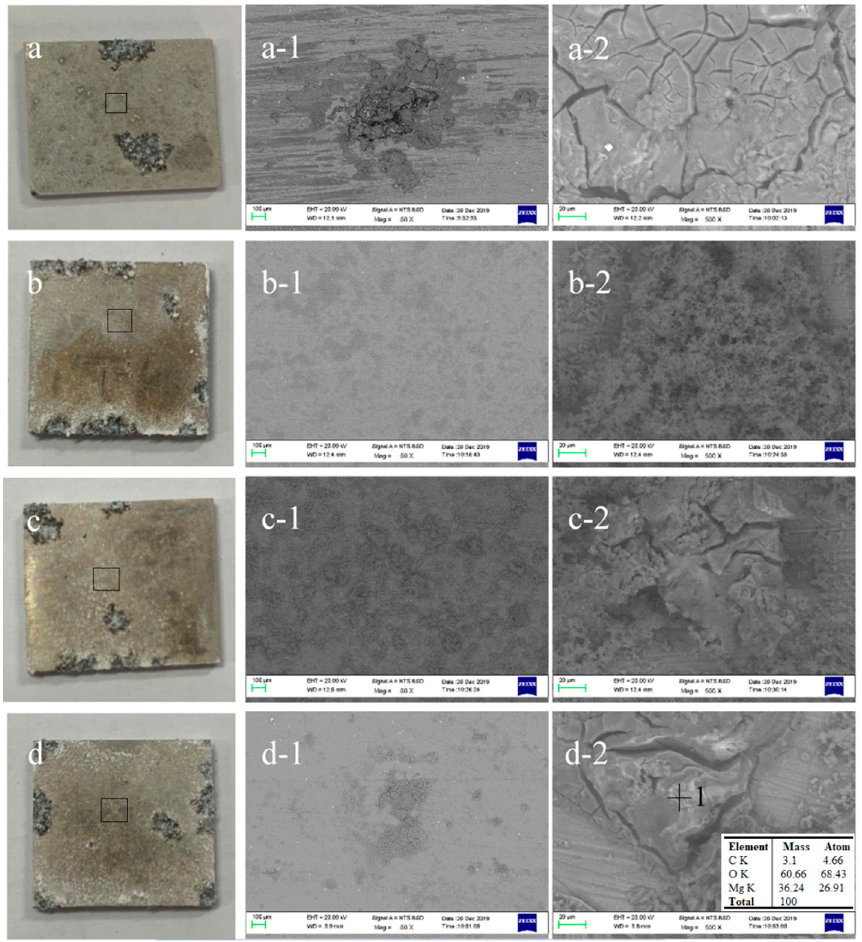
Figure 8. Morphology of the corroded samples: ( a ) BM, ( b ) C1, ( c ) C2, and ( d ) C3; ( i -1 ) low-magnification SEM pictures, and ( i -2 ) high-magnification SEM pictures. EDS results acquired from Point 1 ( i = a, b, c, and d).